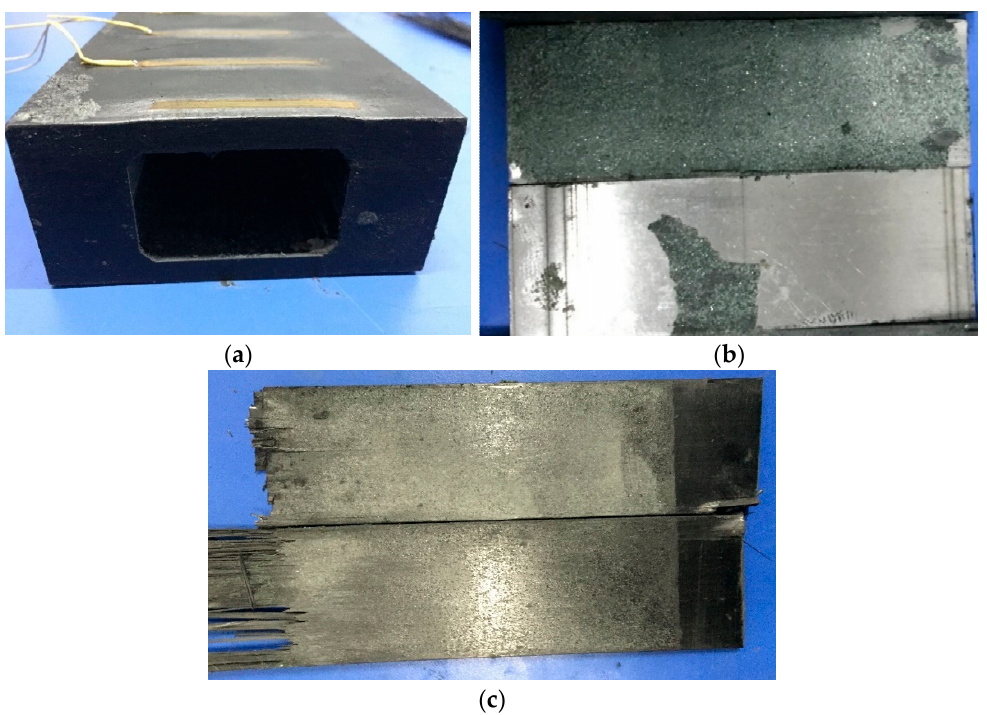
Figure 12. Anchorage after testing. ( a ) Barrel after testing, ( b ) Wedge after testing, ( c ) CFRP plate after testing. Table 3. Static loading test